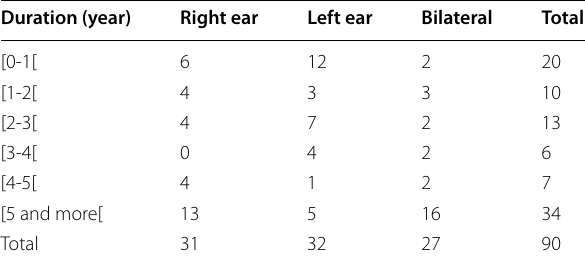
Table 4 Distribution of cases according to the duration of chronic suppurative otitis media and the side of the ear affected